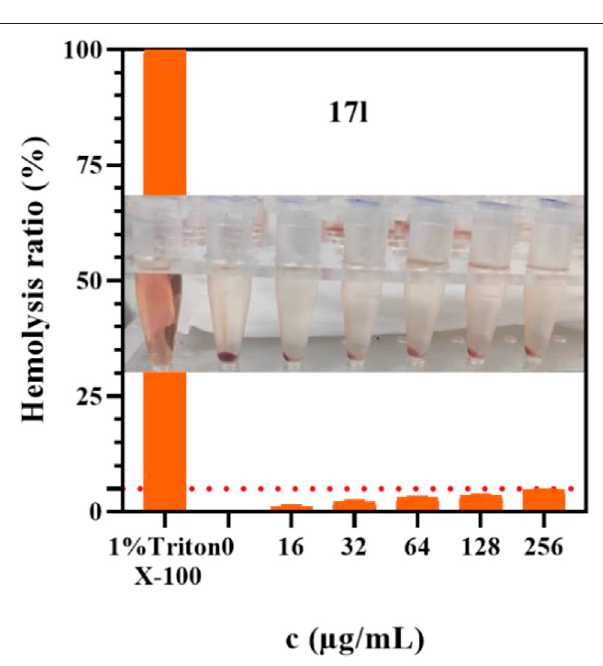
FIGURE 8 | The hemolysis rate of compound 17l with different